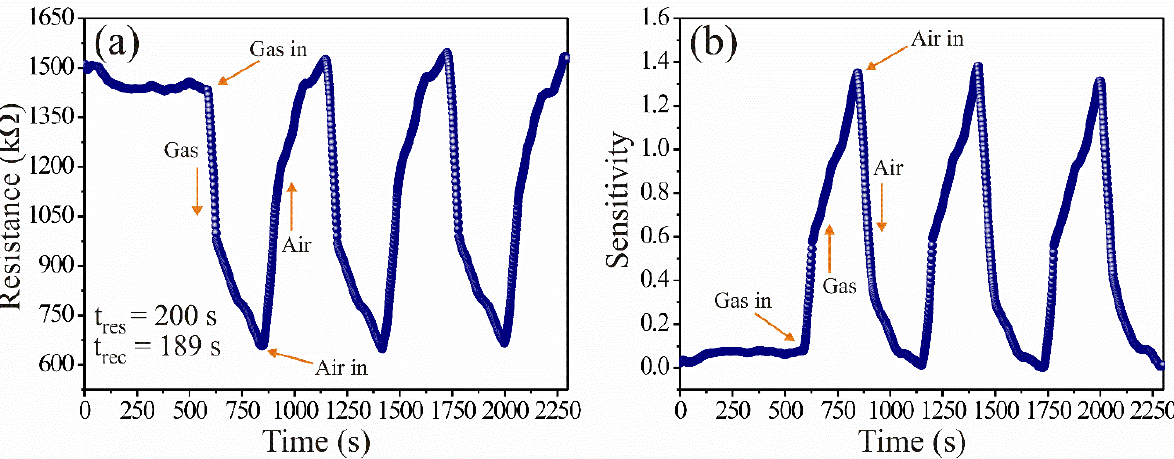
◦ C: ( a ) electrical resistance and ( b ) 2 O 4 at 250